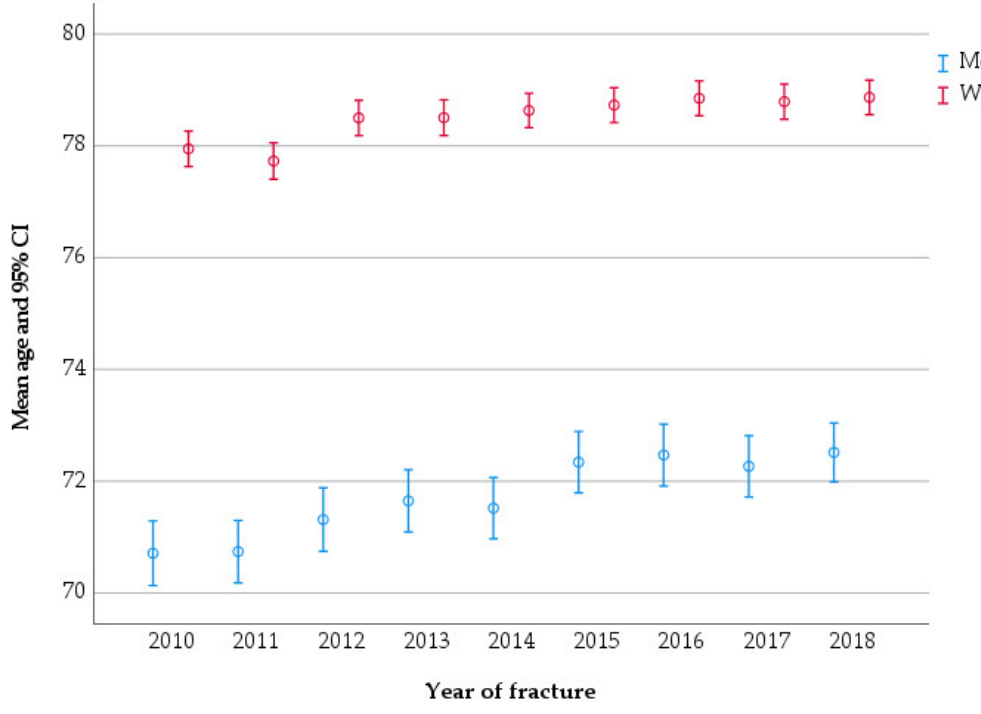
Figure 2. Mean age of patients at pelvic fracture, stratified by the year of fracture. In men, the median age for sustaining a PF was 73 years (IQR 62–81), whereas in women it was 81 years (IQR 72–86).